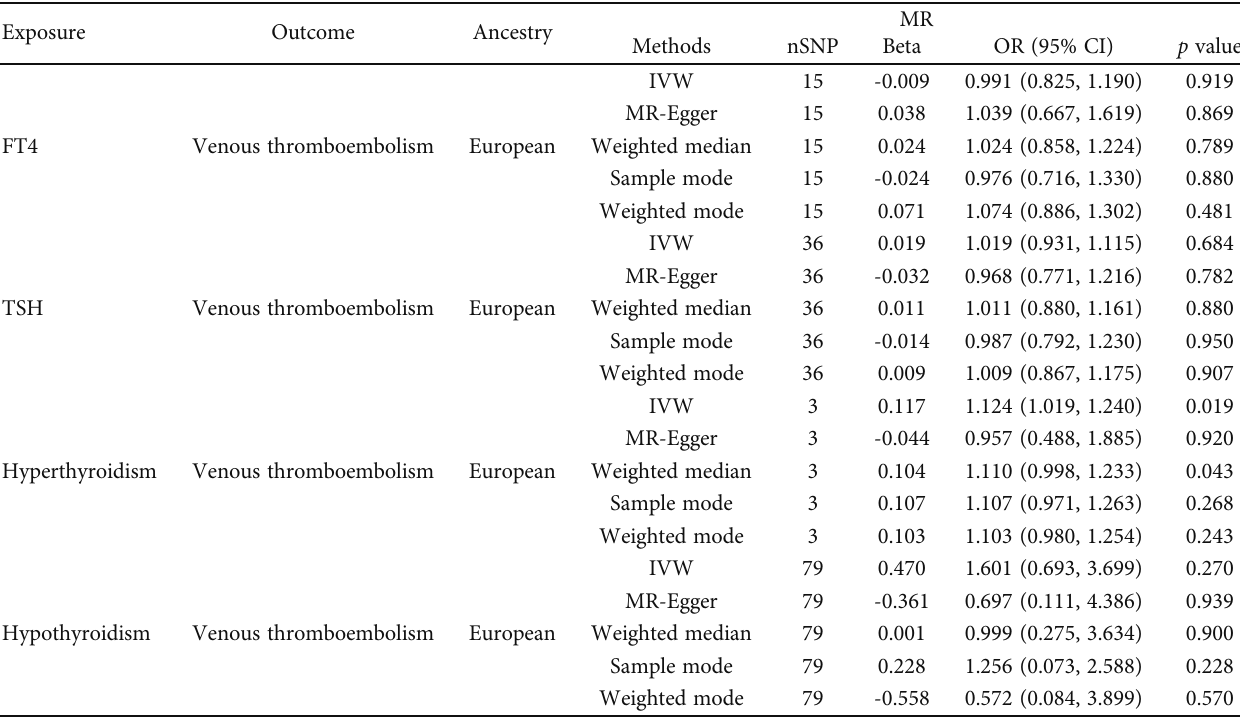
Table 6: Mendelian randomization analysis for estimating the associations between thyroid function and dysfunction and venous thromboembolism risk.